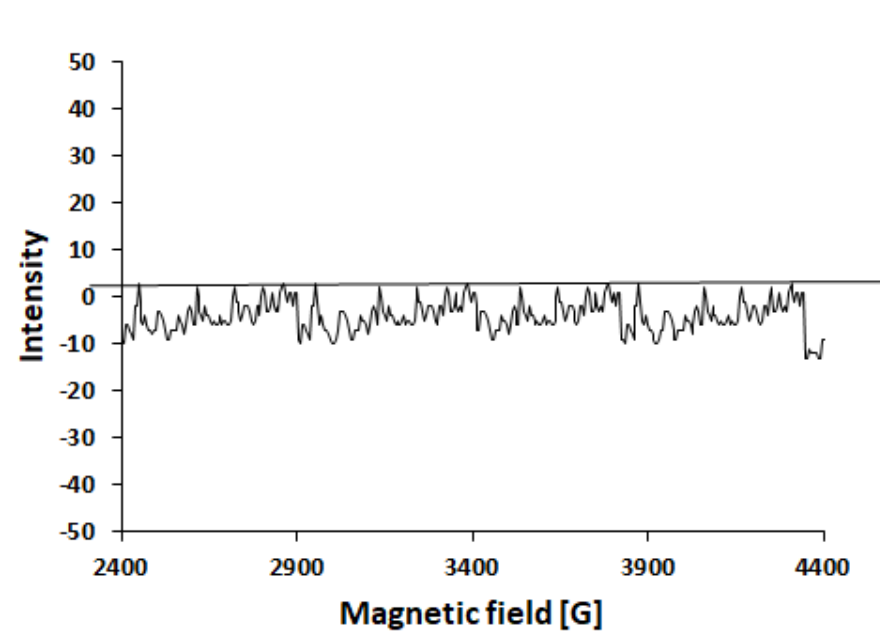
Figure 4. Electron Spin Resonance (ESR) spectra of the samples of water saturated with methane.